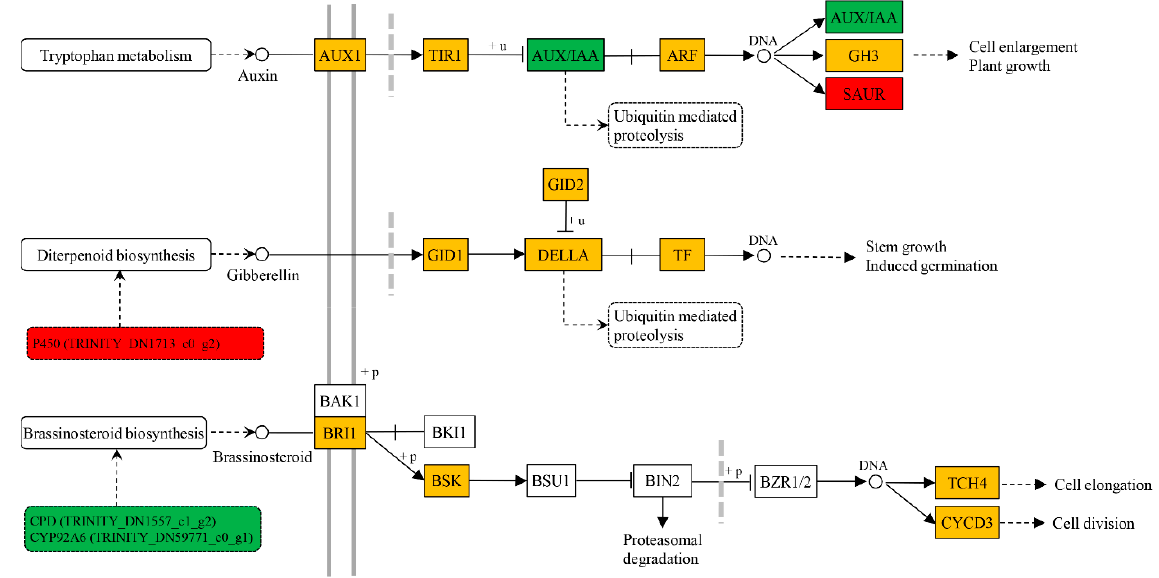
Figure 5. Endogenous hormone biosynthesis and signal transduction of auxin, giberellin and brassinosteroid. +u and +p mean ubiquitination and phosphorylation, respectively. Red and green frames indicate significantly upregulated and downregulated, respectively. Orange frame means gene expression was induced, but not significantly. Table 1. Important genes in biosynthesis, metabolism and signal transduction of endogenous hormones.